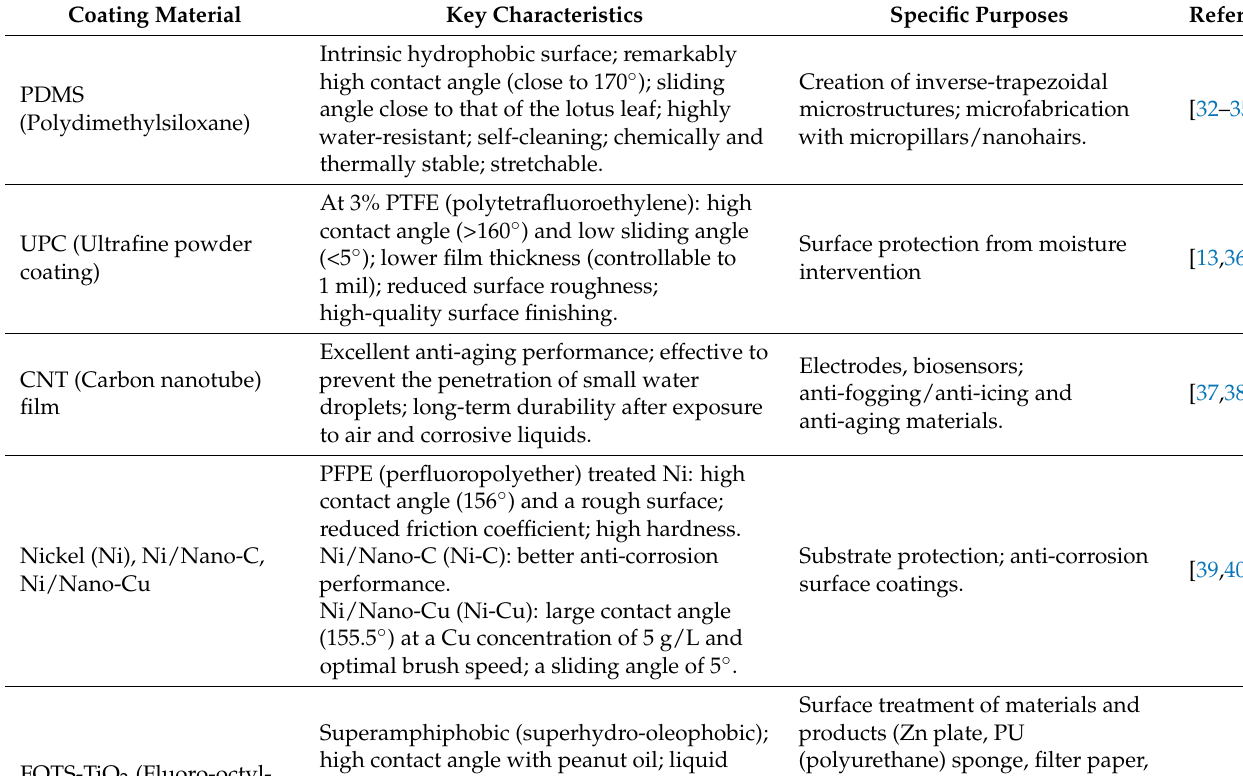
Table 1. Various biomimetic coating